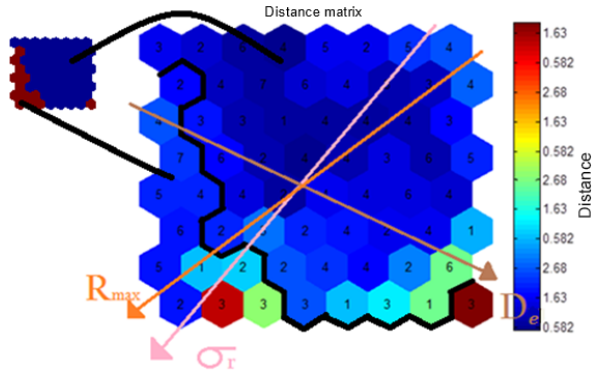
Figure 3. Distance matrix for the M( x Best ) map: the color of each neuron represents the average distance between itself and its neigh- boring neurons. The value inside each neuron indicates the number of rain events that it has captured inside the learning data set. The black line separates the neurons into two classes, using the hierar- chical ascendant classification (see Sect. 4.1). The arrows represent the gradients of the variables R max , σ R and D e